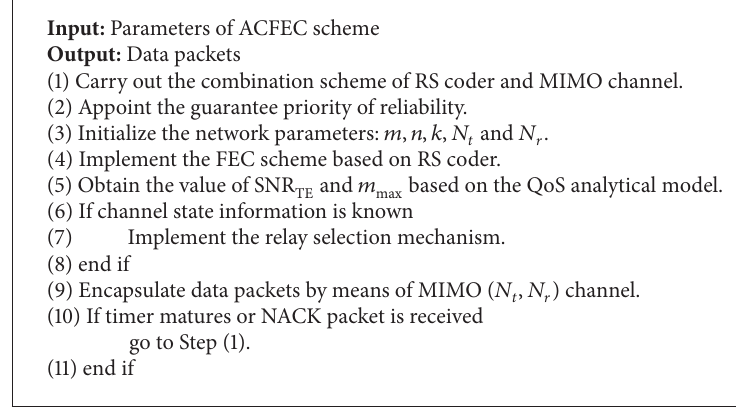
Algorithm 1: Algorithm of ACFEC at sender node.